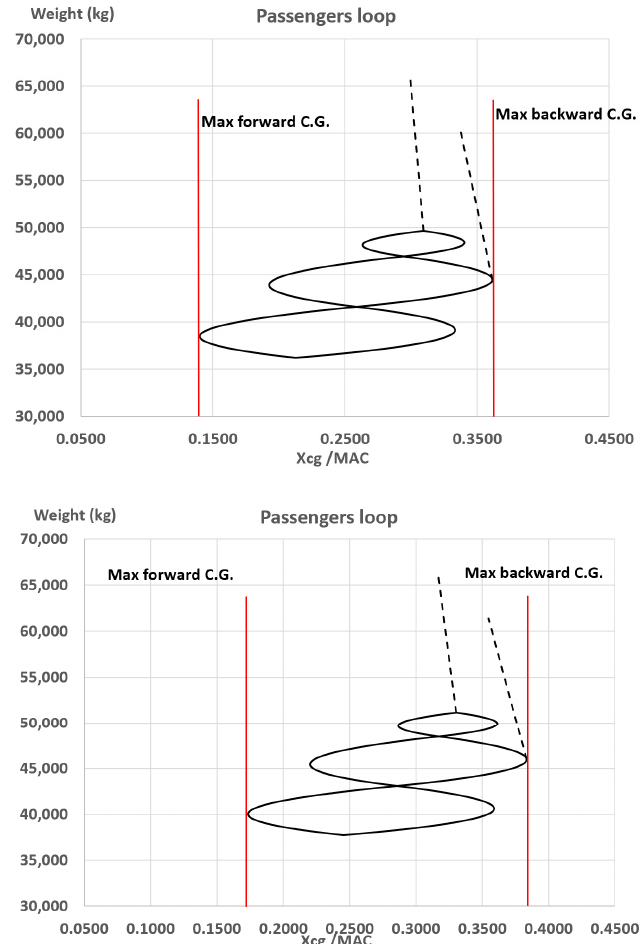
Figure 7. Centre of gravity excursion range: Ref. configuration ( up ) vs. Conf. B ( low ).